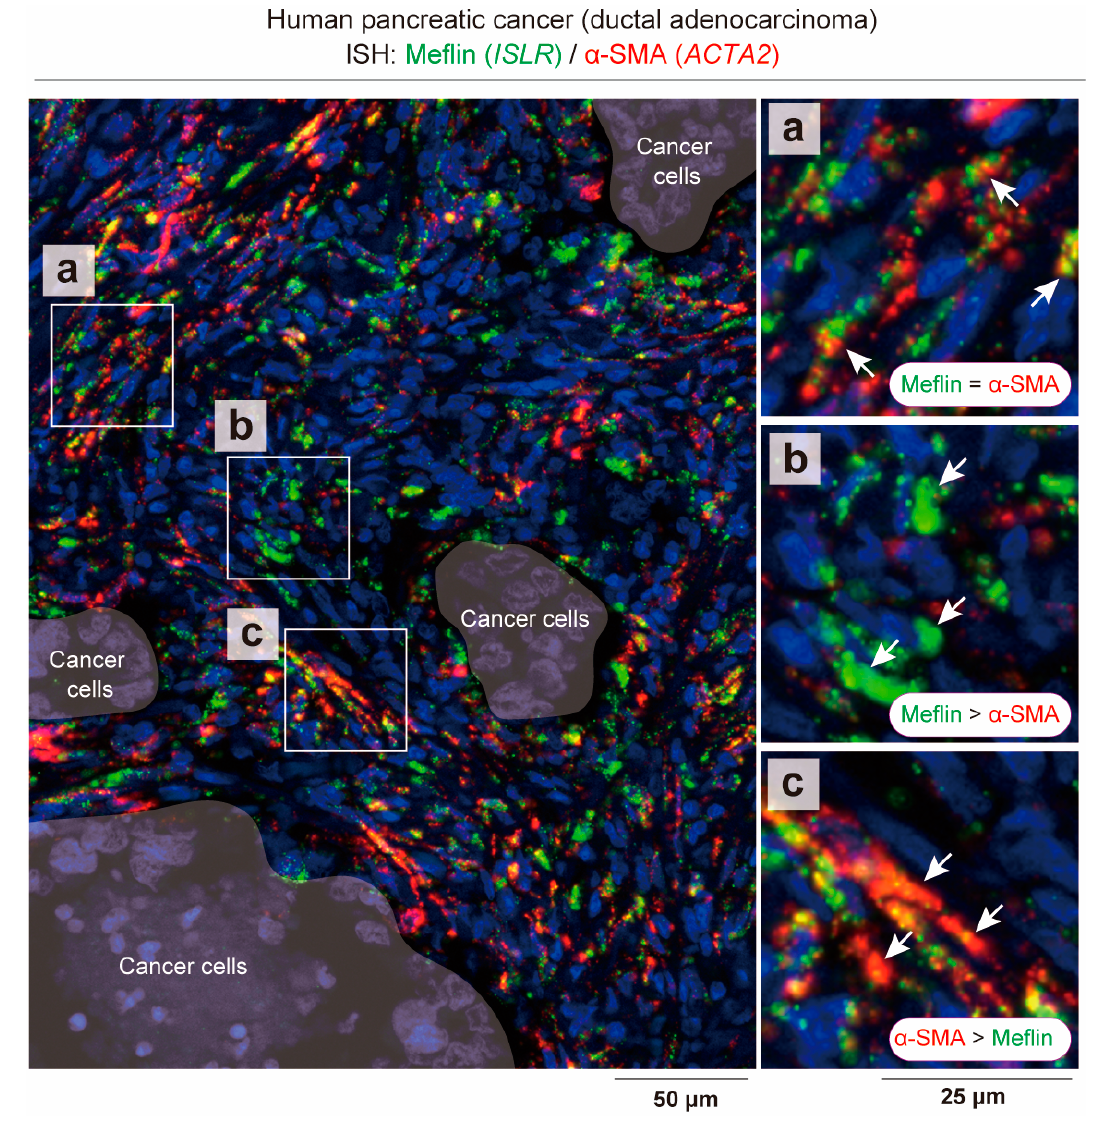
Figure 3. Overlap and continuity in the expression of genes encoding Meflin and α -SMA between different CAFs. Duplex in situ hybridization (ISH) assay shows an overlapping but inverse correlation between Meflin ( ISLR ; green) and α -SMA ( ACTA2 ; red) expression in CAFs infiltrating human PDAC. The boxed areas ( a – c ) are magnified in adjacent panels. The arrows indicate CAFs that exhibit variable levels of Meflin and α -SMA expression. Statistical analysis of the inverse correlation between Meflin and α -SMA expression in CAFs was performed in Mizutani et al. [28].